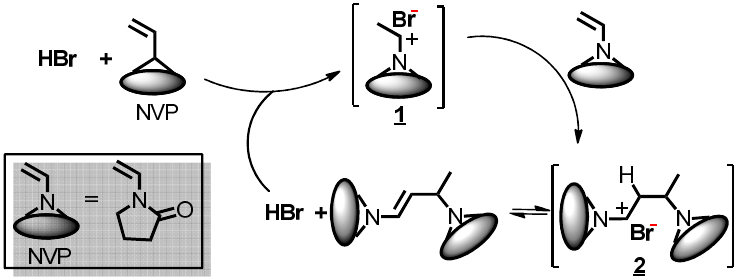
Scheme 2. Proposed acid-catalyzed dimerization mechanism during ATRP of PVBBPA with NVP.